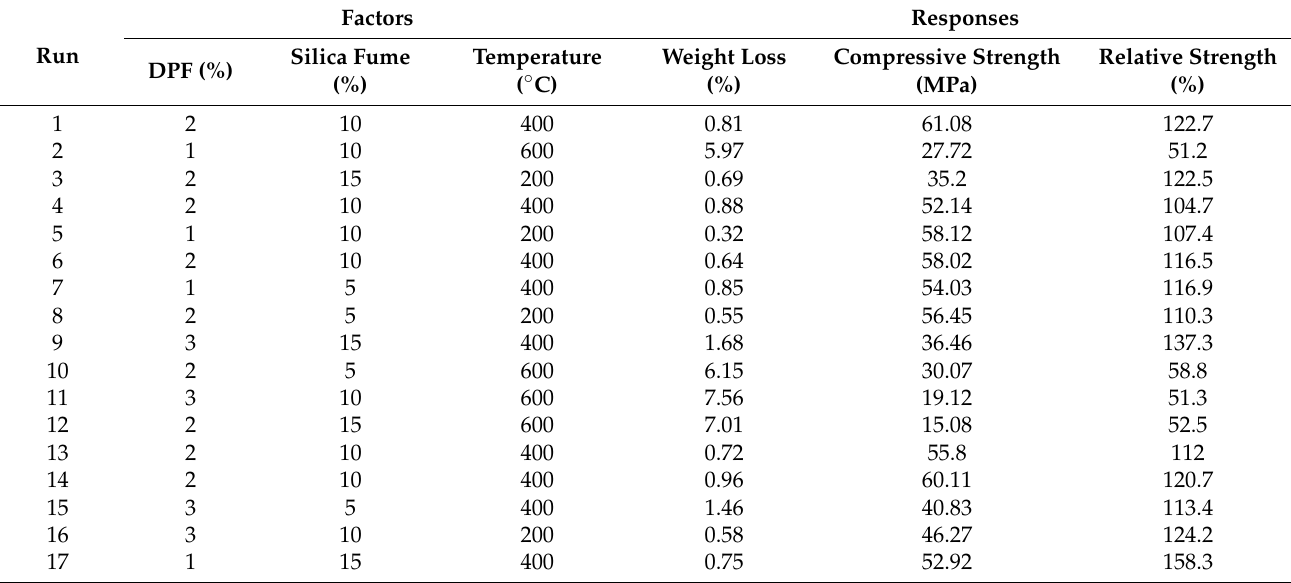
Table 6. Mix proportions and results from